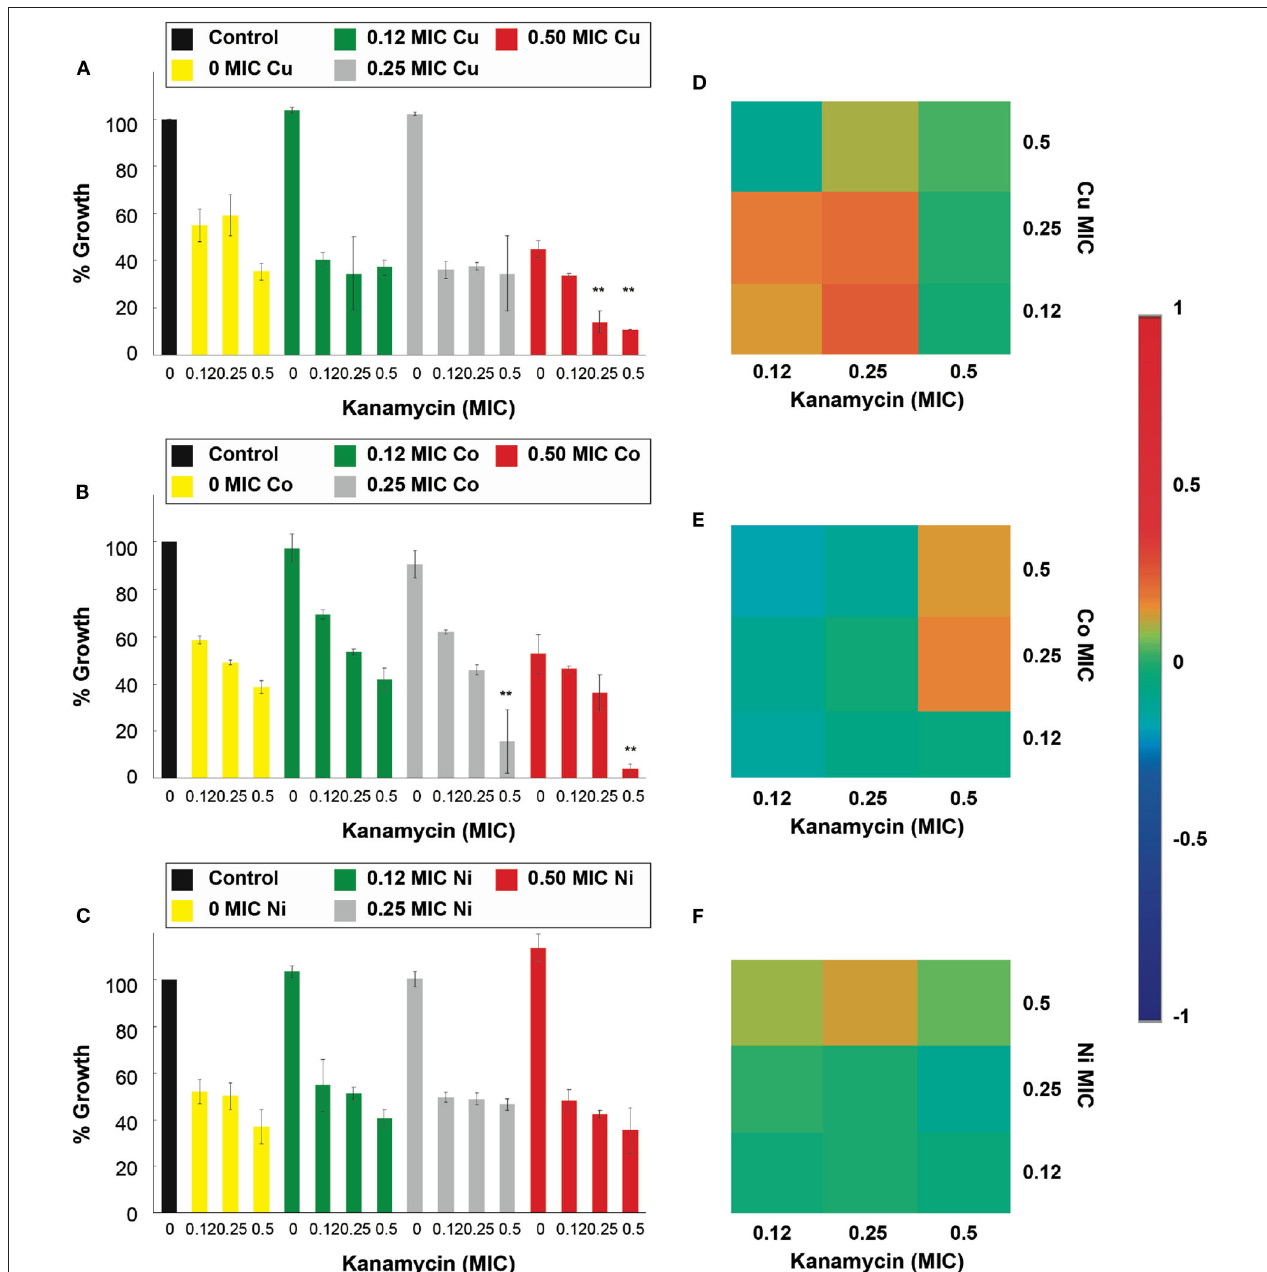
FIGURE 3 | Antimicrobial effect and interactions of ATMCs in E. coli . Growth percentage by sub-inhibitory concentrations of metal ion-antibiotic combinations: (A) Cu 2 + -kanamycin, (B) Co 2 + -kanamycin, and (C) Ni 2 + kanamycin against E. coli ATCC 11229. Classification of the different interactions between metal ion-antibiotic combinations. The interactions of (D) Cu 2 + -kanamycin, (E) Co 2 + -kanamycin, and (F) Ni 2 + -kanamycin combinations are classified as synergistic, additive or antagonist, value > 0, = 0, and < 0, respectively. Each experiment was done in triplicates. **Corresponds to a significant difference ( p < 0.05) concerning the control and each of the individual treatments. Error bars correspond to the standard deviation from experiments performed in triplicates.